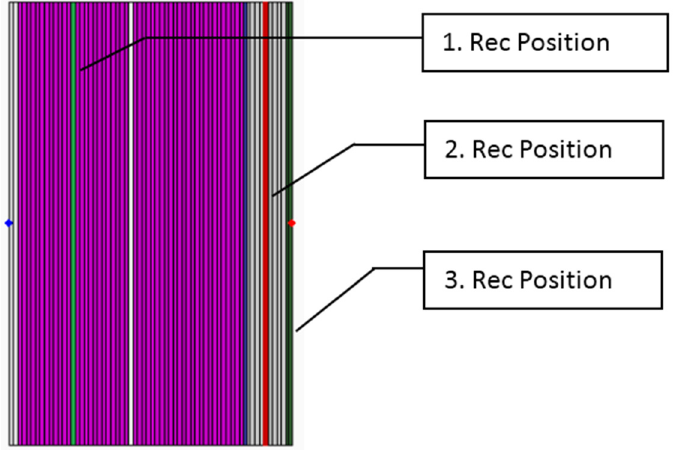
Figure 2. The recorder